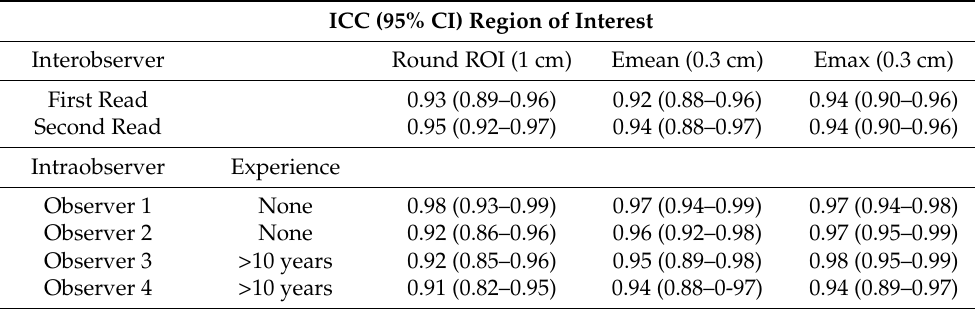
Table 2. Interclass correlation coefficients of inter- and intraobserver agreement in Group 2. ICC (95% CI) Region of